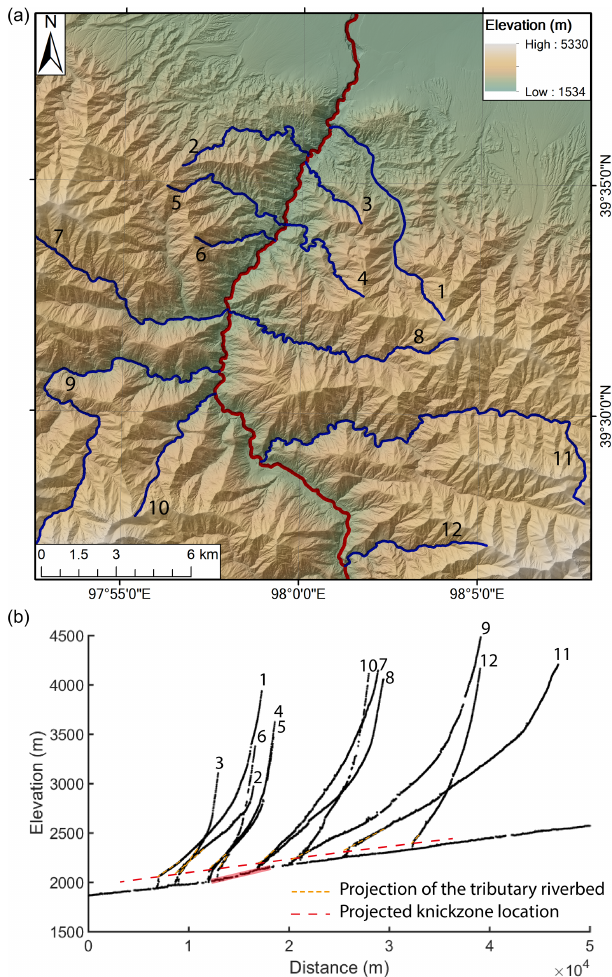
Figure 4. (a) Map of the tributaries of the Beida River. Red de- lineates the main stem; blue delineates tributaries. (b) Longitudinal profiles of the tributaries of the Beida River, as numbered in (a) . The main-stem knickzone is highlighted in red. Dashed red line connects the projection of tributary streams to the junction with the main stem based on stream gradient above each tributary